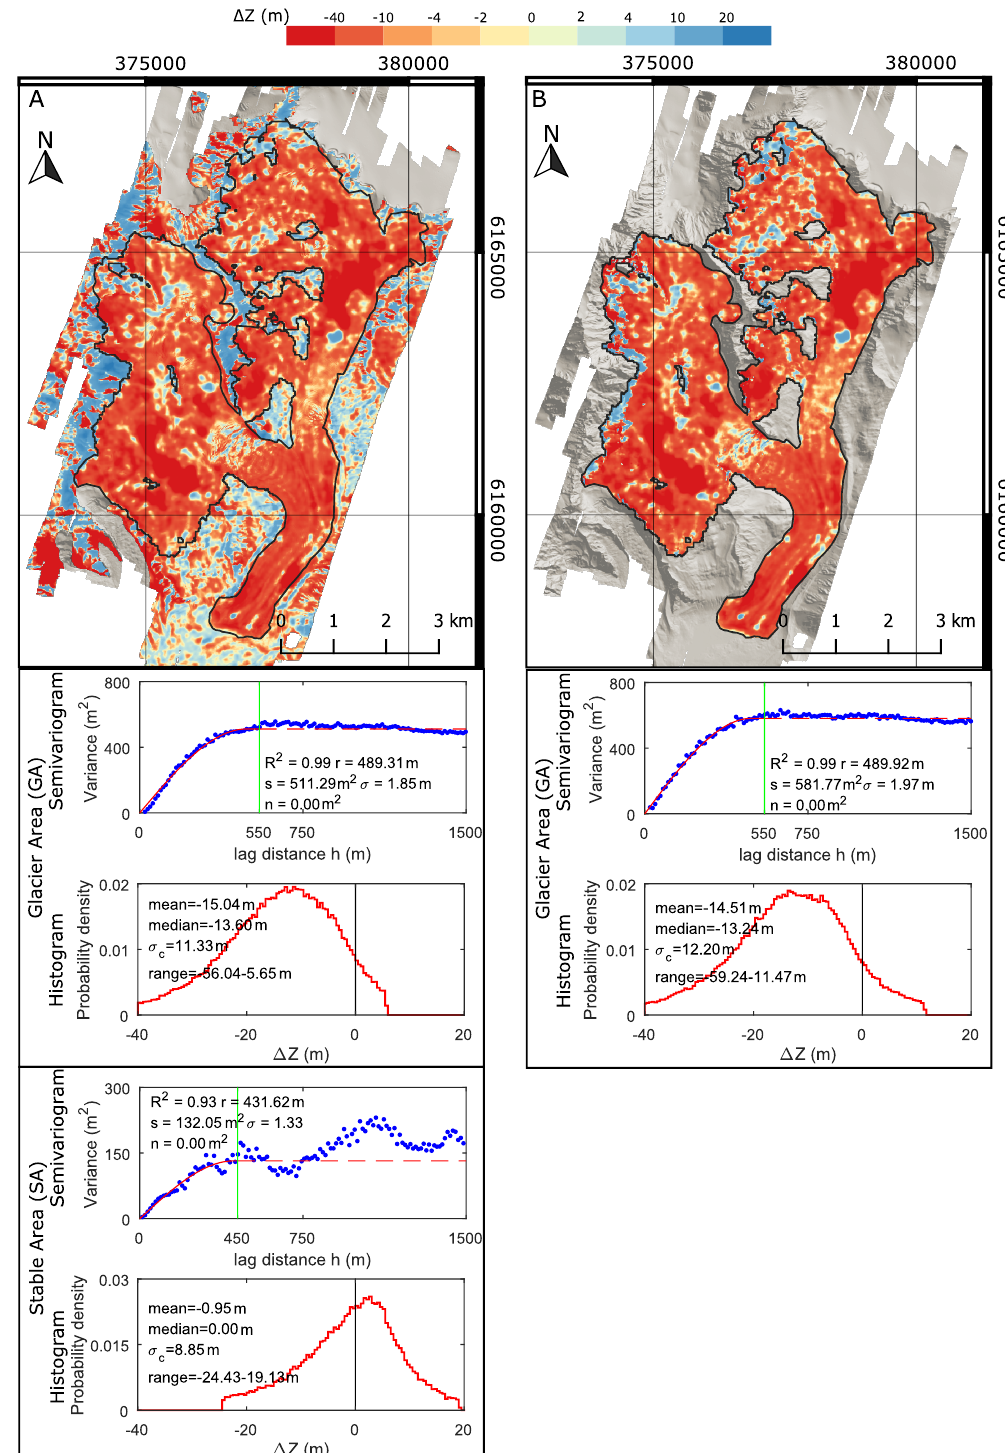
Figure 7. Results of DEM subtraction with semivariograms and histograms of differences. ( A ): ALS- ASTER; ( B ): TanDEM-ASTER. Resolution of both maps is 12 m. Blue dots represent empirical semivariograms, while red lines—synthetic ones. Green vertical line indicates distance threshold of the best fit of the model to the data. Black line on the map delimits the